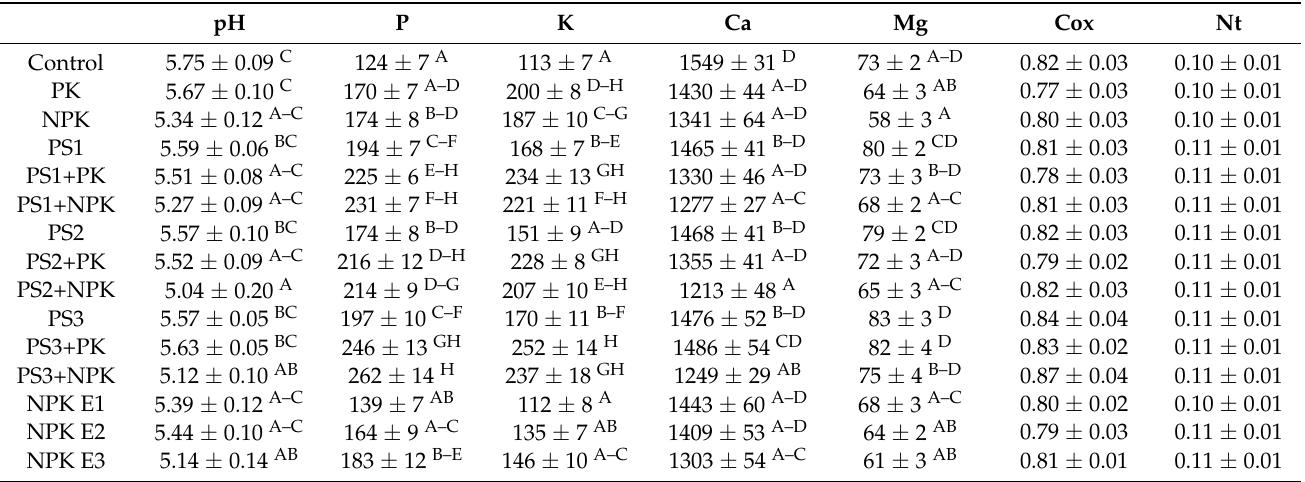
Table 5. Soil pH value, the concentration of P, K, Ca and Mg (mg kg − 1 ), the content of organic carbon (Cox, %) and total nitrogen (Nt, %) as affected by the fertilizer treatments (2015–2020) in Kostelec. pH P K Ca